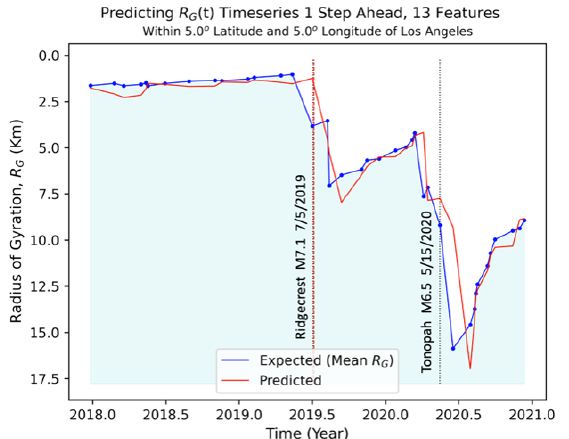
Figure 4. An example of a time series prediction using the RFC